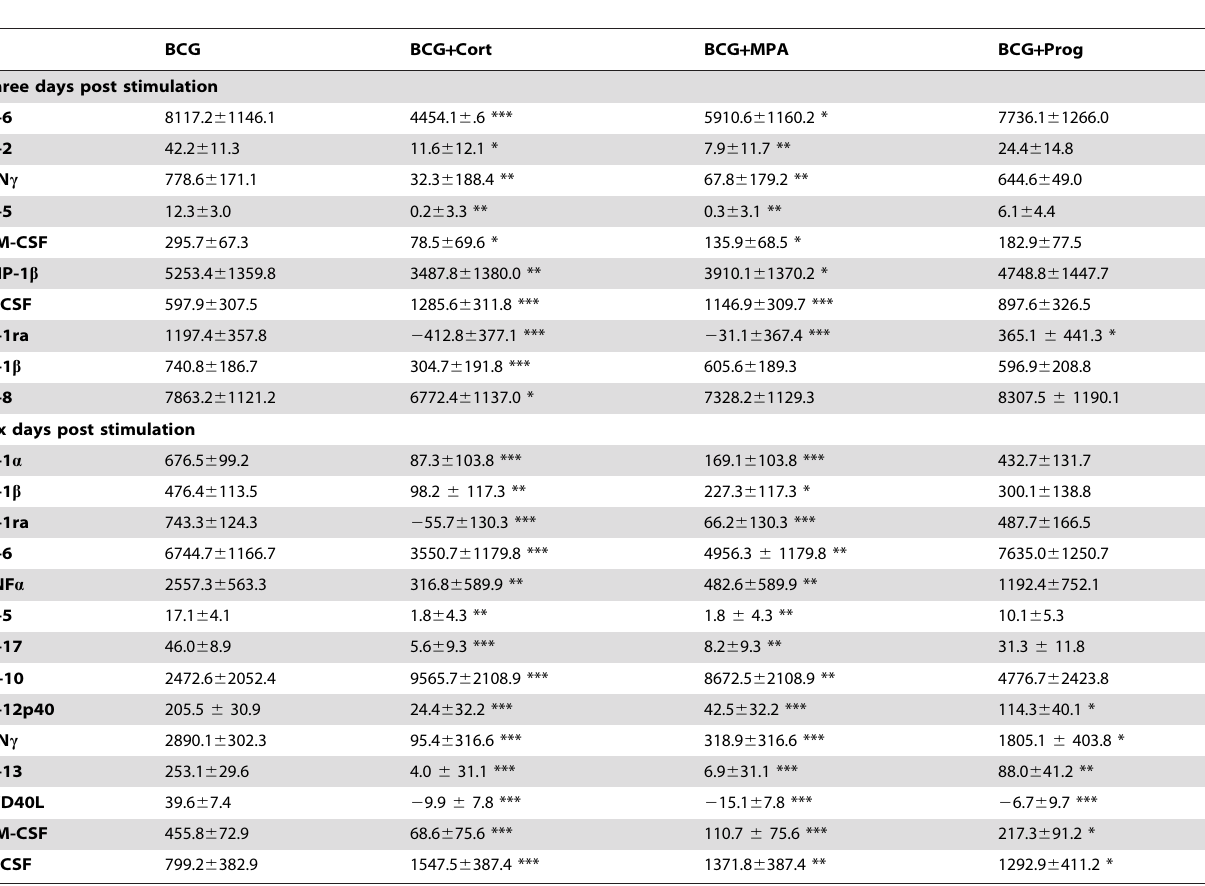
Table 1. The effect of cortisol, MPA and progesterone on cytokine production three and six days post stimulation of PBMCs with